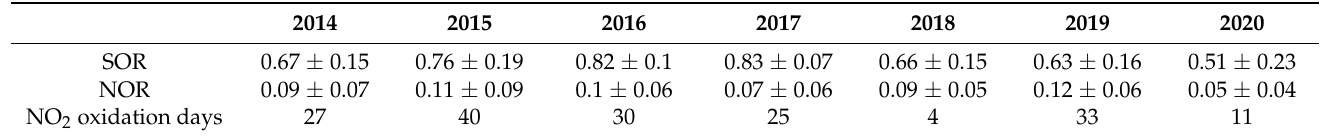
Table 3. Seasonal sulfur oxidation rate (SOR) and nitrogen oxidation rate (NOR).